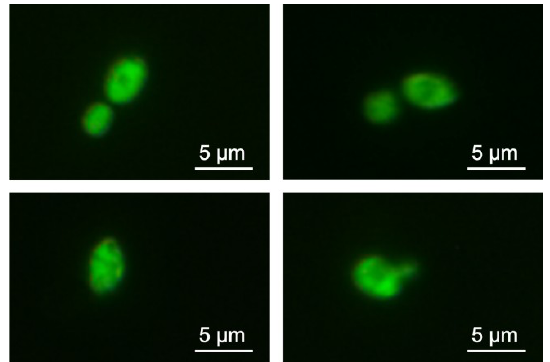
Figure 6. Binding of fluorescein isothiocyanate (FITC)-anionic peptide 2 to C. albicans cells. The cells were incubated in the presence of FITC-labeled AP2 (5 μM) at 37 °C for 15 min and then imaged by laser scanning confocal microscopy.